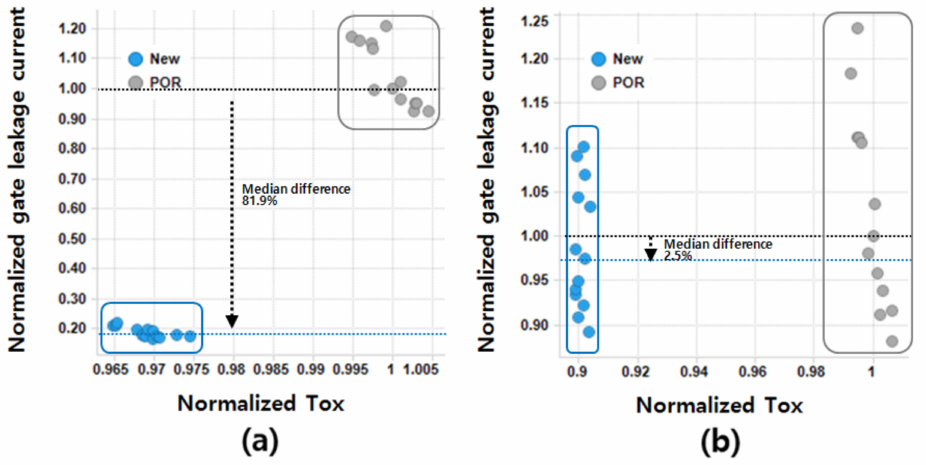
Figure 4. Normalized gate leakage current vs. normalized electrical oxide thickness for ( a ) NFET and ( b )